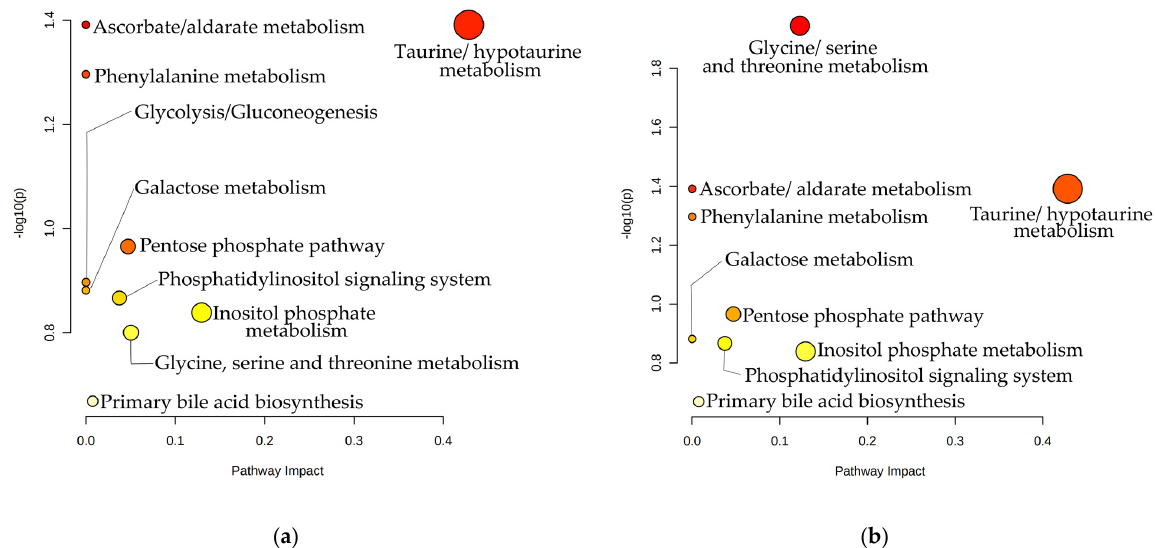
Figure 8. Graphically representation of the pathway analysis. Each cycle represents a metabolic path- way, while the color and the size are based on p -value and pathway impact, respectively. ( a ) Pathway analysis of EOS group significant metabolites. ( b ) Pathway analysis of LOS significant